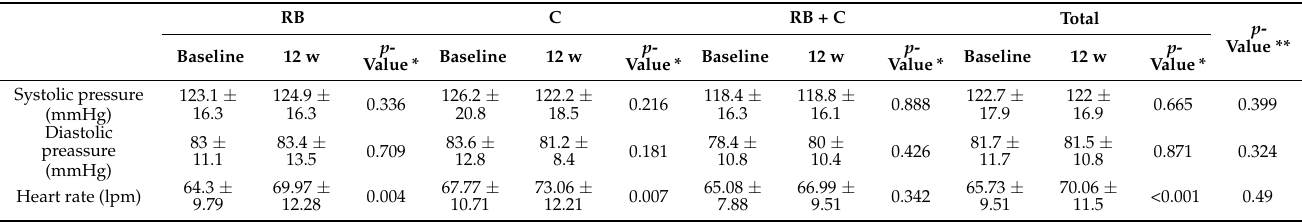
Table 3. Blood pressure values in each group and by